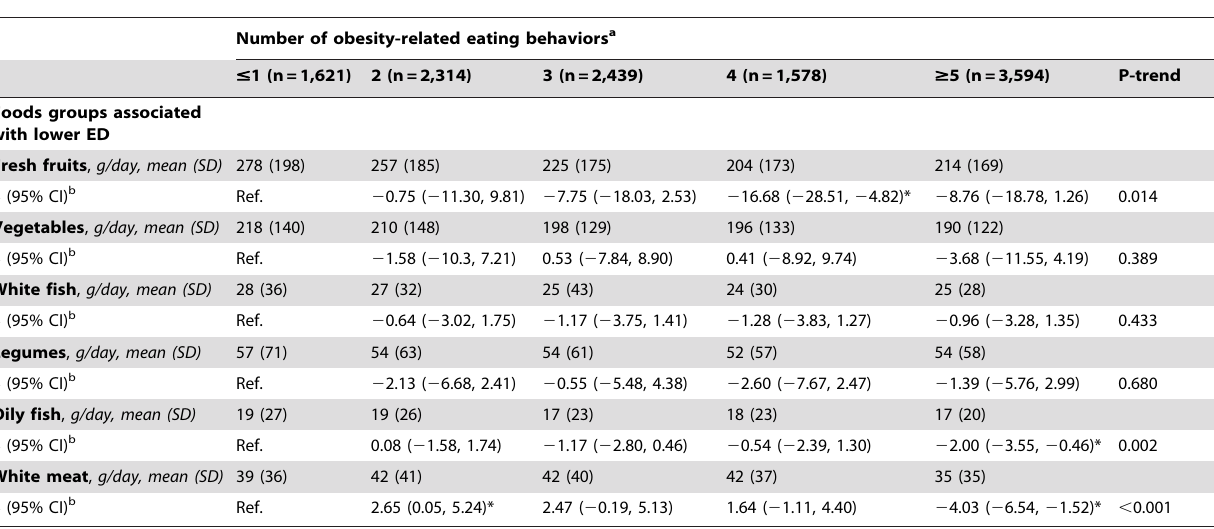
Table 7. Association of the number of obesity-related eating behaviors with individual foods groups associated with lower energy density